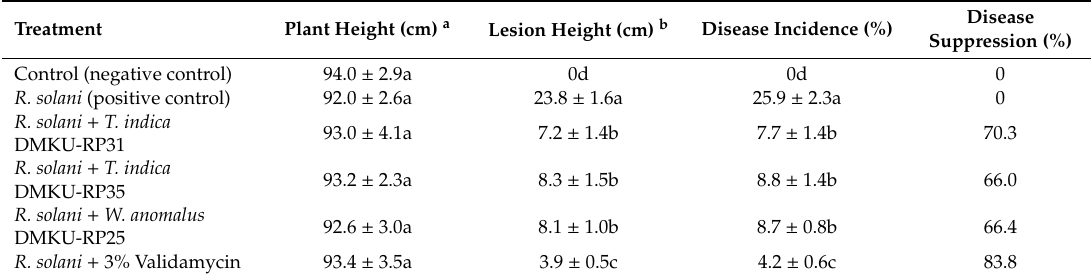
Table 7. Efficacy of the antagonistic yeasts in suppressing of rice sheath blight disease caused by R. solani DOAC 1406 in rice plants grown in pots in the greenhouse.